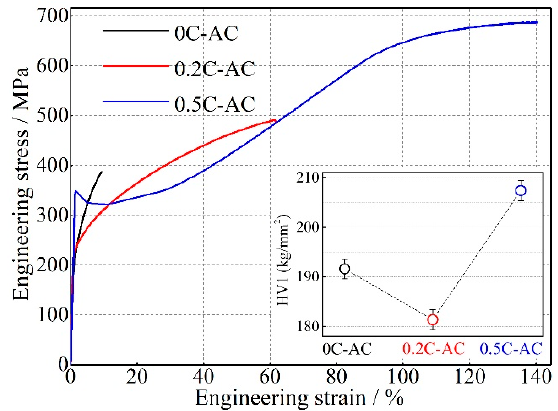
Figure 5. Engineering stress–strain curves and hardness distribution of the as-cast Fe50Mn30Co10Cr10 alloys with different carbon contents.